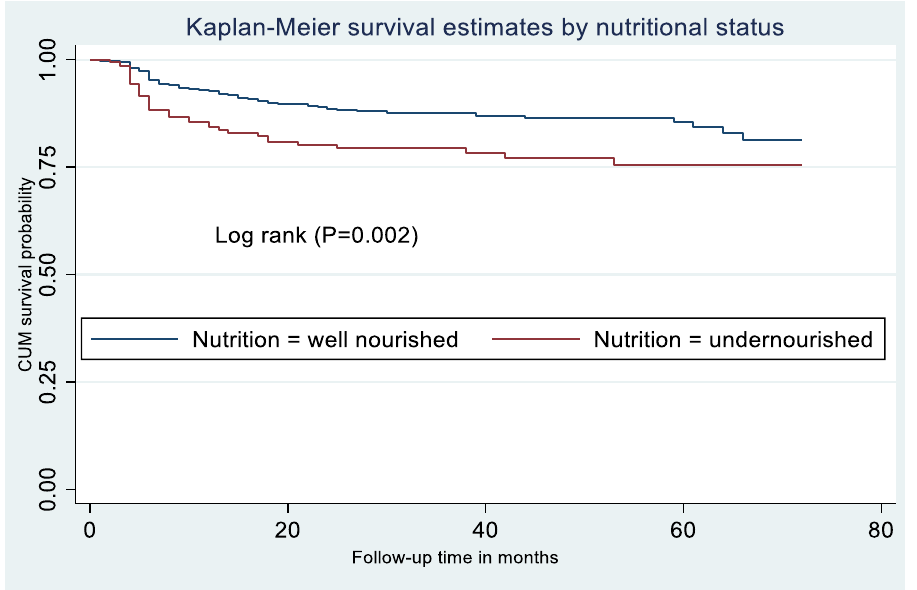
Figure 3. Kaplan–Meier survival curves to compare LTFU among undernourished and well-nourished adults living with HIV on ART at Debre Markos Comprehensive Specialized Hospital, Northwest Ethiopia, 2021.